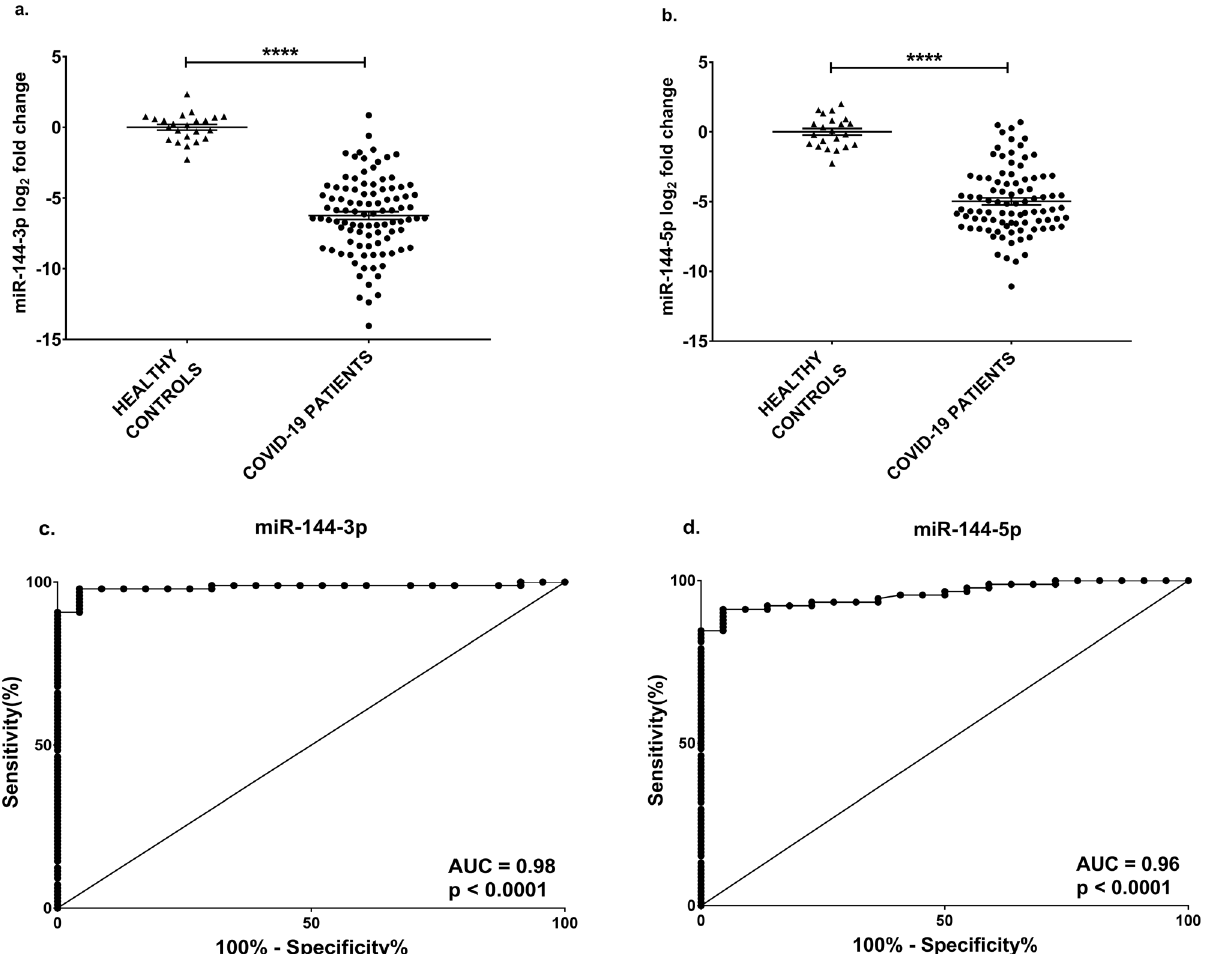
Figure 2. miR-144 levels are decreased in hospitalized COVID-19 patients and discriminate patients from healthy controls. miR-144-3p ( a ) and miR-144-5p ( b ) plasma levels were measured by qPCR. Values are expressed as log 2 fold change compared to controls and shown as dot- plots indicating mean ± SEM. Unpaired t-test (two groups) was used for statistical comparison. The ROC curves show the sensitivity and specificity of miR-144-3p ( c ) and miR-144-5p ( d ) to distinguish COVID-19 patients hospitalized at PSD from healthy controls. Controls n = 23; COVID-19 patients n = 97; **** p ≤